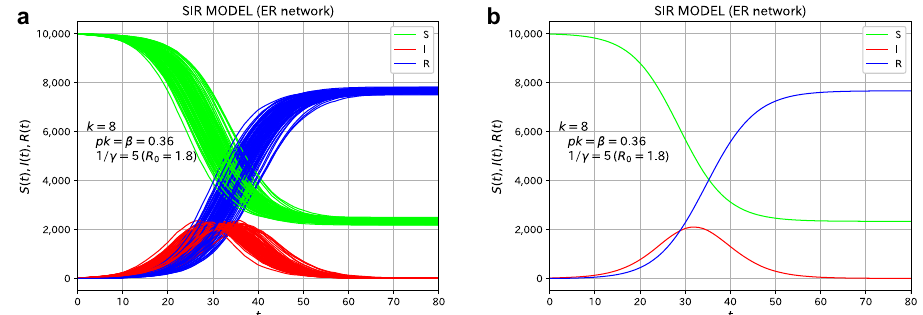
Figure 1. The simulational results of the microscopic SIR model on the ER network (reference system with no variants). ( a ) the plot of all 100 samples assumed to be infected with the virus with R 0 = 1.8 . ( b ) the average over 100 samples. Initially, 10 individuals were set to be